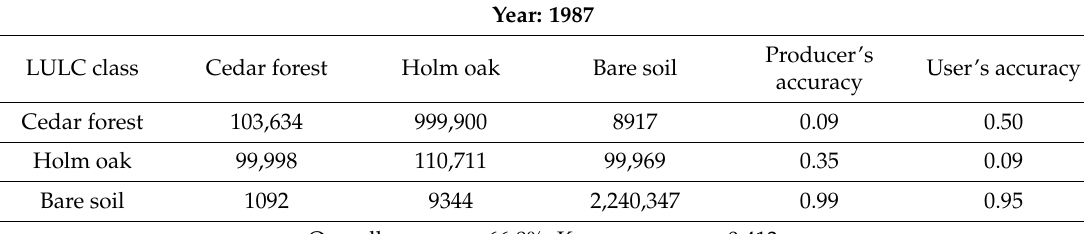
Table 5. Accuracy assessment of the land cover maps